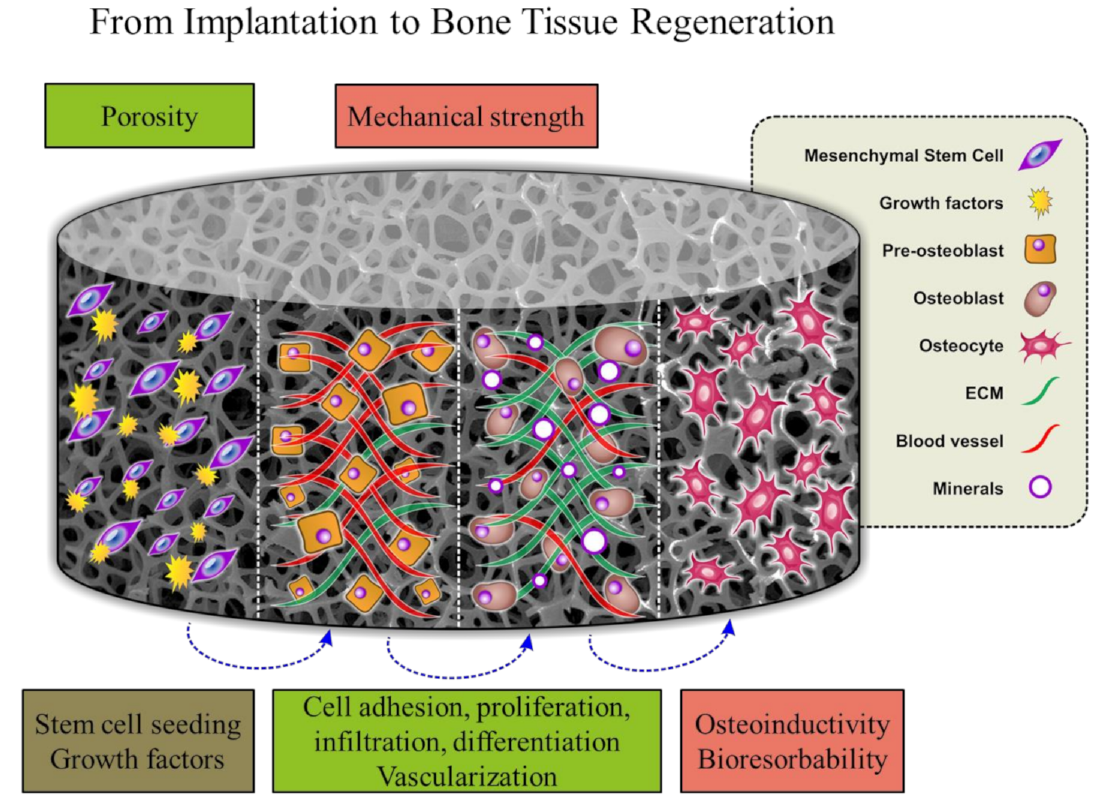
Figure 2. Bone formation followed by scaffold implantation. Reproduced from [28] with permission from Wiley.